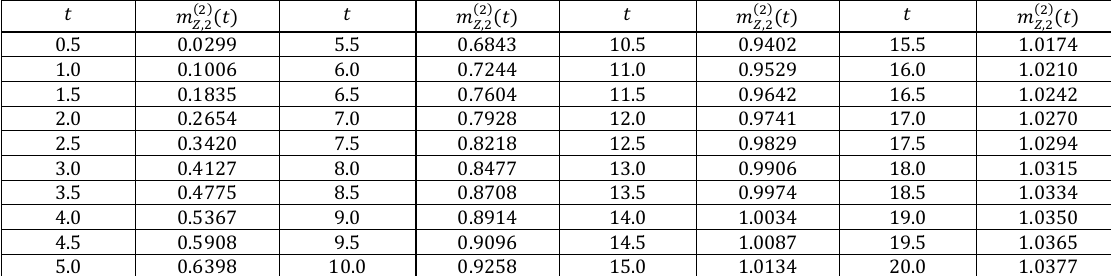
Table 5. Environment level 2 dependent growth of maligant cells (Two mutation)